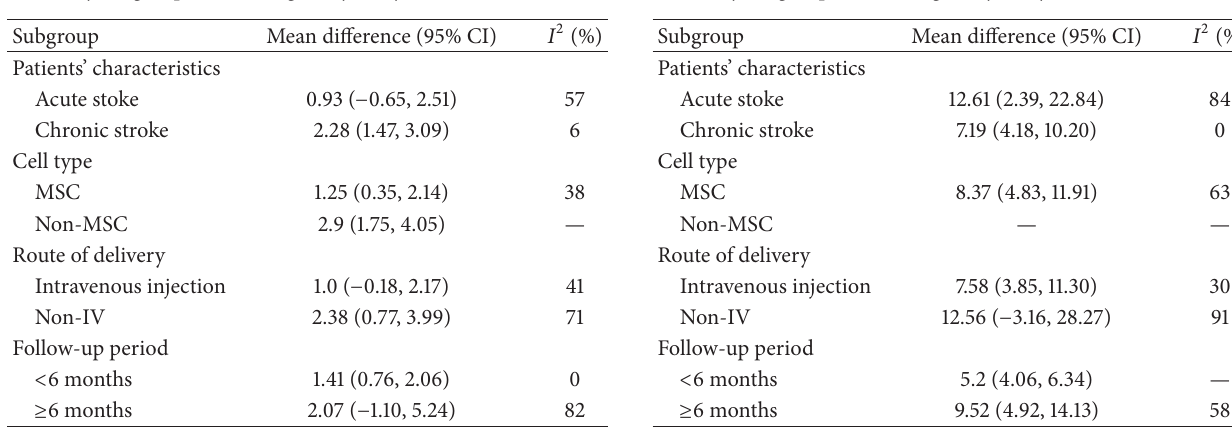
Table 3: The correlations of NIHSS and clinical variables across studies by subgroup and heterogeneity analysis.